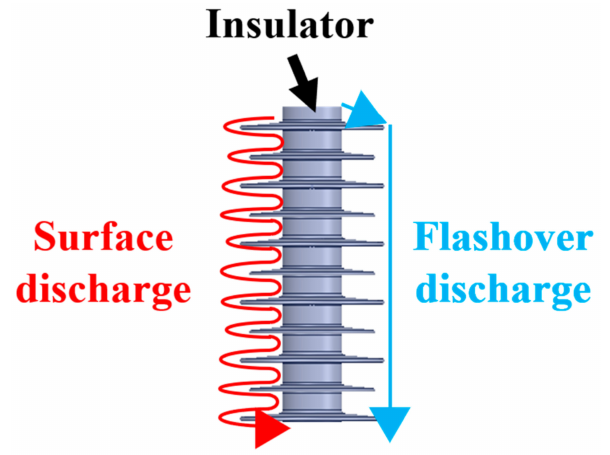
Figure 5. Surface discharge path and flashover discharge